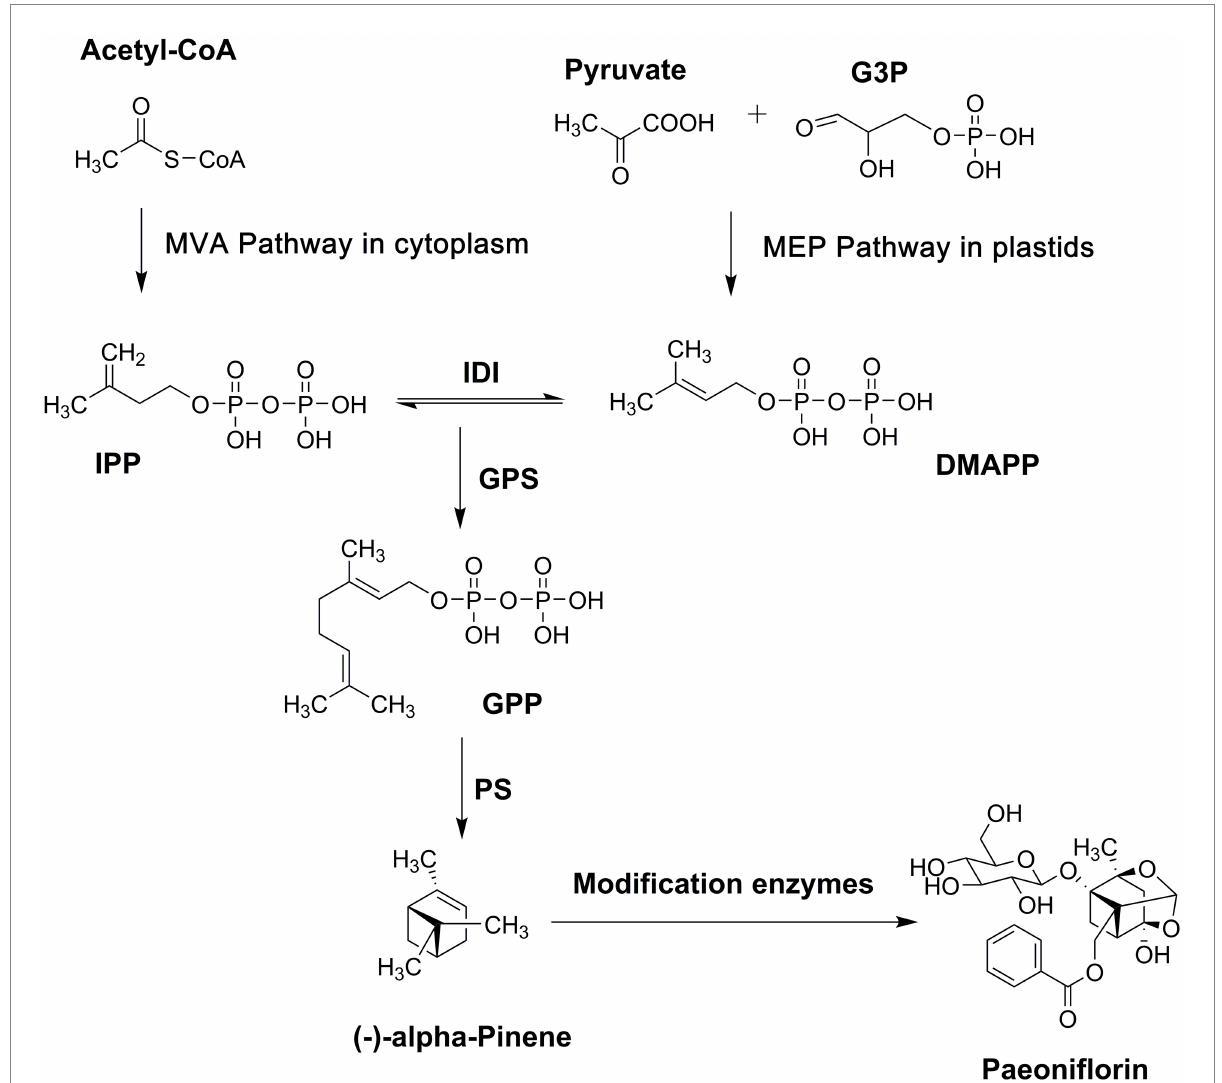
FIGURE 1 Biosynthesis pathway of paeoniflorin. G3P, glyceraldehyde-3-phosphate; MVA, mevalonate; MEP, 2-C-methyl-D-erythritol4-phosphate; IPP, isopentenyl pyrophosphate; DMAPP, dimethylallyl diphosphate; IDI, isopentenyl diphosphate isomerase; GPS, geranylgeranyl pyrophosphate synthase; GPP, geranyl diphosphate; PS, pinene